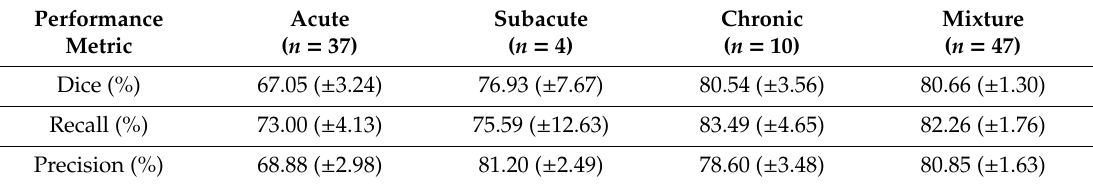
Table 2. Mean of the segmentation performance metrics for acute, subacute, and chronic types and their mixture. Numbers in parentheses are 68% of standard error of the mean.